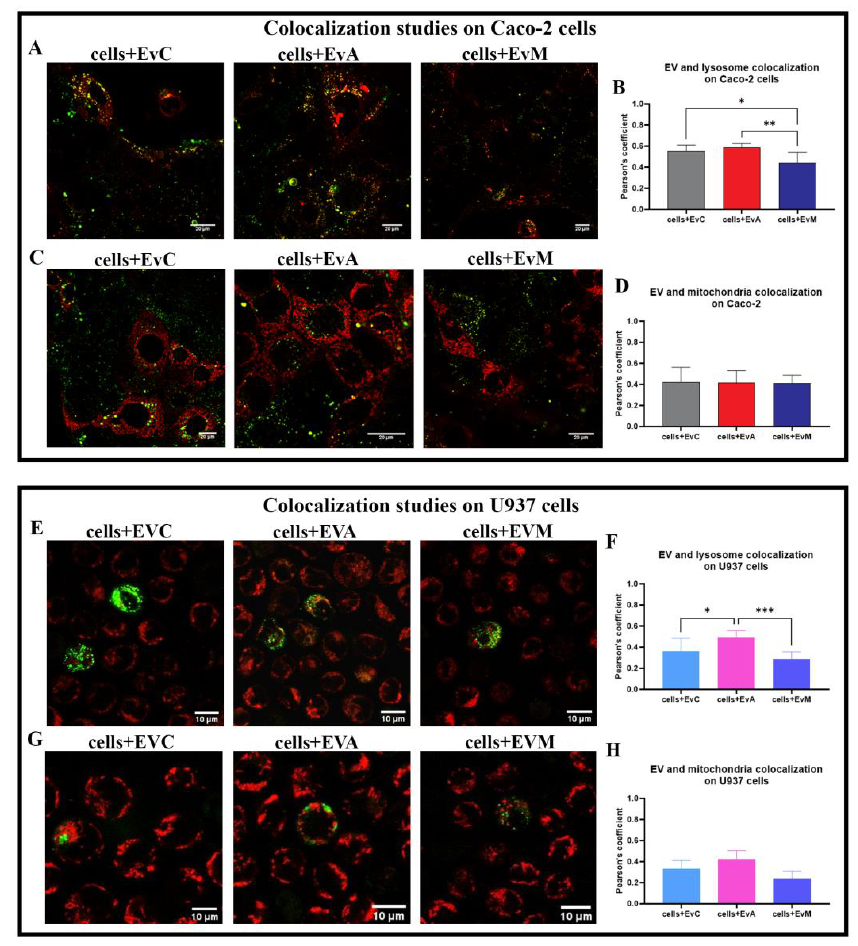
Figure 7. ( A ) Single confocal optical sections of Caco-2 cells showing an overlay of the lysosome (LTDR red) and EVs (PKH67 green) at 48 h for the cells + EvC, cells + EvA, and cells + EvM. Colocalisation of the EVs (green) and lysosomes (red) is displayed in yellow. The bar indicates 20 µ m. ( B ) Pearson’s coefficient, able to quantitate LTDR/EV co-localisation for the cells + EvC, cells + EvA, and cells + EvM. Pearson’s coefficients were derived from three biological replicates with >10 fields per experiment contributing to the cumulative result. ( C ) Single confocal optical sections of Caco-2 showing an overlay of the mitochondria (TMRE red) and EVs (PKH67 green) at 48 h for the cells + EvC, cells + EvA, and cells + EvM. The bar indicates 20 µ m. ( D ) Pearson’s coefficient, able to quantify TMRE/EV co-localisation for the cells + EvC, cells + EvA, and cells + EvM. Pearson’s coefficients were derived from three biological replicates with >10 fields per experiment contributing to the cumulative result. ( E ) Single confocal optical section of U937 displaying an overlay of the lysosomes (LTDR red) and EVs (PKH67 green) at 48 h for the cells + EvC, cells + EvA, and cells + EvM. Colocalisation of the EVs (green) and lysosomes (red) is displayed in yellow. The bar indicates 10 µ m. ( F ) Pearson’s coefficient, able to quantitate LTDR/EV co-localisations for the cells + EvC, cells + EvA, and cells + EvM. Pearson’s coefficients were derived from three biological replicates with >10 fields per experiment contributing to the cumulative result. ( G ) Single confocal optical section of U937 displaying an overlay of the mitochondria (TMRE red) and EVs (PKH67 green) at 48 h for the cells + EvC, cells + EvA, and cells + EvM. Colocalisations of the EVs (green) and mitochondria (red) are displayed in yellow. The bar indicates 10 µ m. ( H ) Pearson’s coefficient, able to quantitate TMRE/EV co-localisations for the cells + EvC, cells + EvA, and cells + EvM. Pearson’s coefficients were derived from three biological replicates with >10 fields per experiment contributing to the cumulative result. One-way ANOVA with Bonferroni’s multiple comparison test. The asterisk denotes a statistically significant difference (* = p < 0.05, ** = p < 0.01, *** = p <